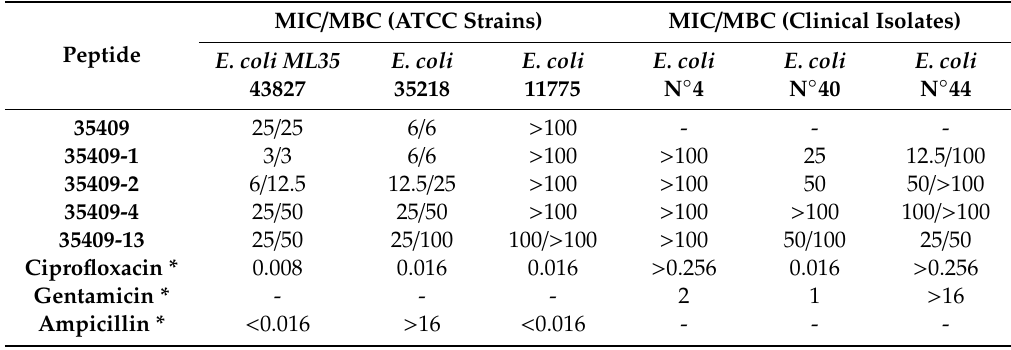
Table 3. Antibacterial activity of 35409-derived peptides against ATCC strains and E. coli clinical isolates. Peptide MIC and MBC are expressed in µ M.